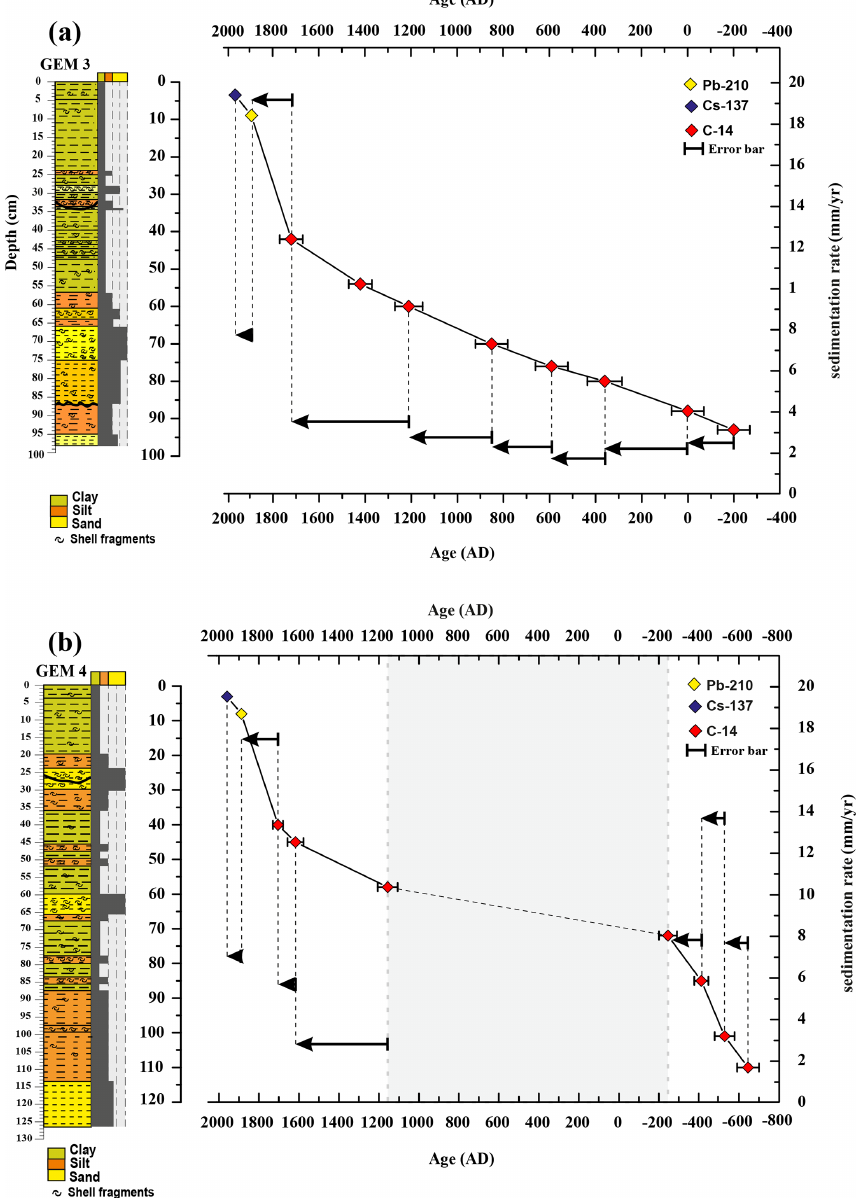
Figure 5. (a) Sediment age–depth for the core GEM3 sampled from Ghar El Meleh lagoon (arrows: sedimentation rate variation). OxCal 4.3 has been used to calculate the age model with eight samples for 14 C dates and only one sample for Pb and Cs dates. (b) Sediment age–depth for the core GEM3 sampled from Ghar El Meleh lagoon (arrows: sedimentation rate variation). OxCal 4.3 has been used to calculate the age model with seven samples for 14 C dates and only one sample for Pb and Cs dates. The blue band determines a period of inactive deposition process or erosion of so-called “a condensed